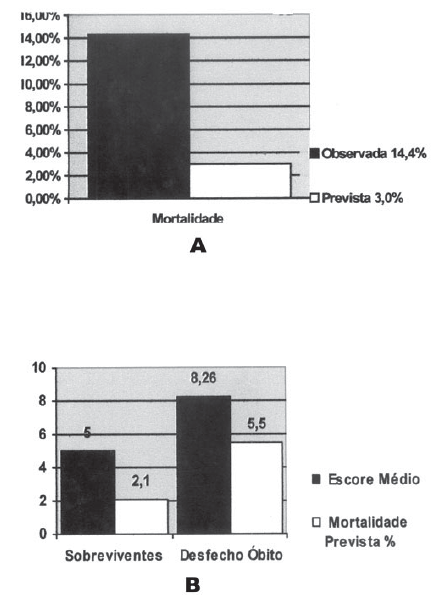
Fig. 1 – A: Mortalidade prevista x observada; B: Escore x mortalidade